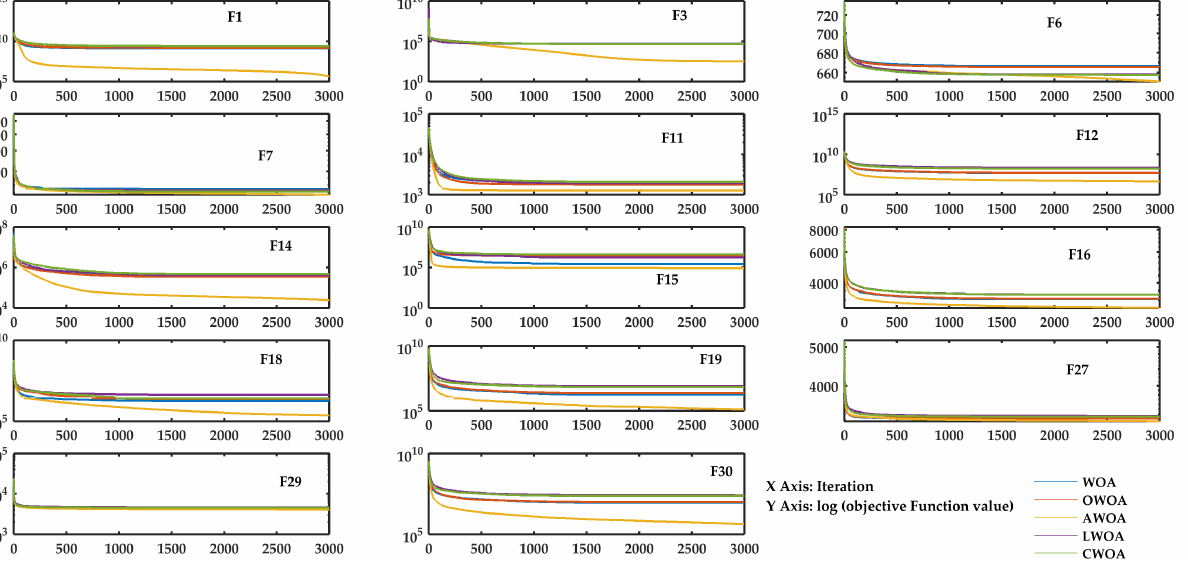
Figure 13. Convergence property analysis of some 30D functions of Benchmark Suite